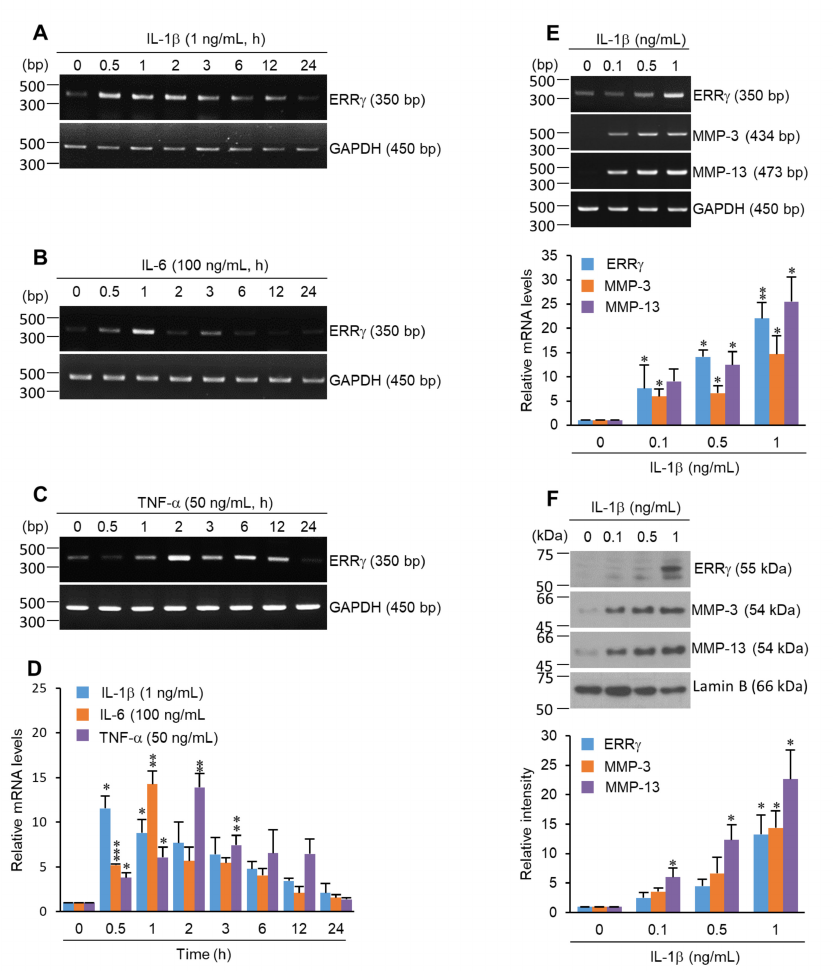
Figure 1. Pro-inflammatory cytokines induce ERR γ expression. The primary cultured articular chondrocytes were exposed to IL-1 β (1 ng / mL) ( A ), IL-6 (100 ng / mL) ( B ), and TNF- α (50 ng / mL) ( C ) for the indicated time course, and ERR γ expression was analyzed using RT-PCR and quantified by qRT-PCR ( D ). Chondrocytes treated with IL-1 β (0–1 ng / mL), and the expression levels of ERR γ , MMP-3, and MMP-13 were analyzed with RT-PCR and quantified by qRT-PCR ( E ). Protein levels were analyzed by Western blotting with semi-quantification ( F ). The results are representative of three independent experiments from di ff erent pups. Values are presented as mean ± standard error of the mean (SEM) (* p < 0.05, ** p < 0.01, and *** p < 0.001). One-way ANOVA was performed. GAPDH and Lamin B were used as internal markers. ERR γ , estrogen-related receptor γ ; IL-1 β , interleukin-1 β , IL-6, interleukin 6; TNF- α , tumor necrosis factor- α ; MMP-3, matrix metalloproteinase-3;